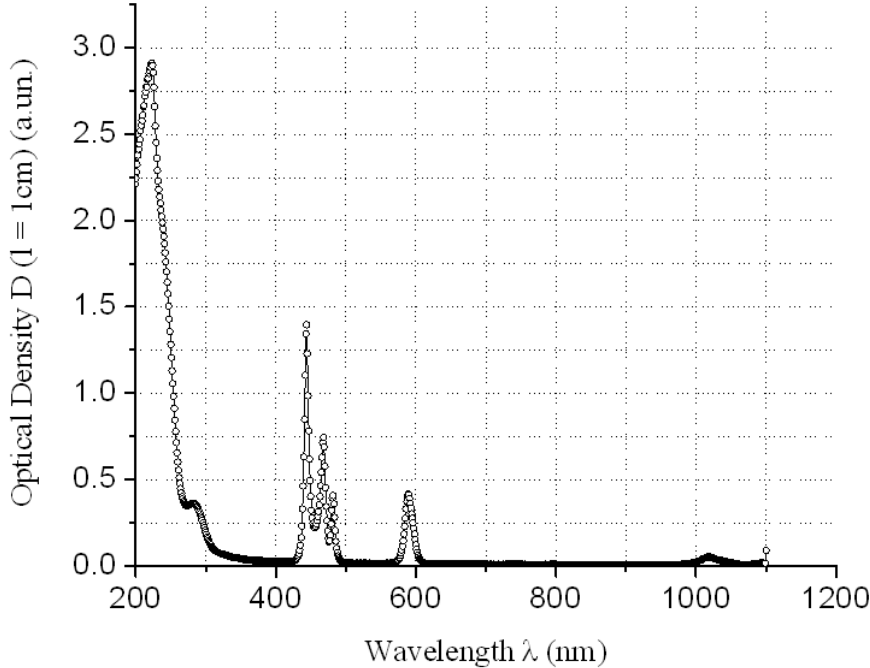
Figure 3. Electronic spectrum of water solution of PrCl 3 at concentration C PrCl3 ≈ 50.7 g/dm 3 relatively distilled H 2 O.